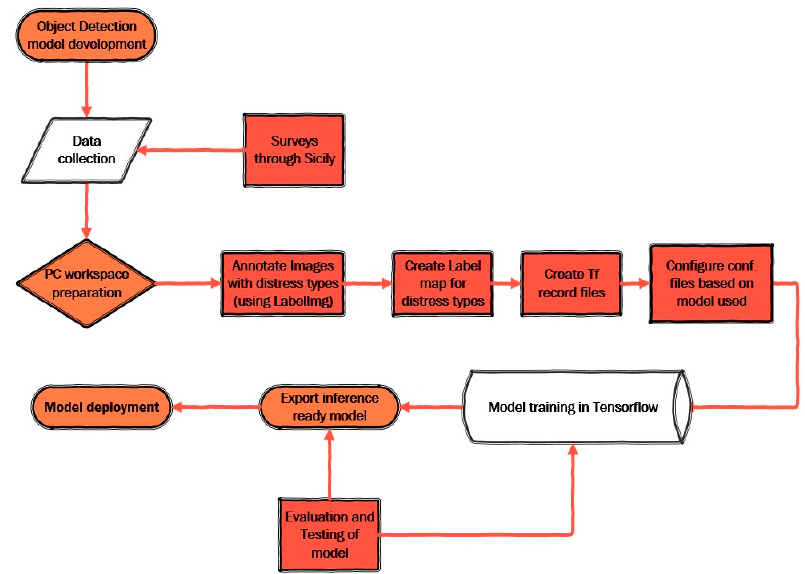
Figure 3. Pipeline utilized for the development of object detection model.